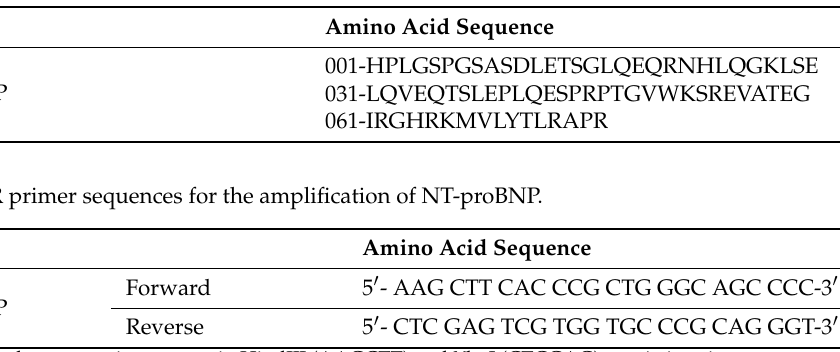
Table 1. NT-proBNP amino acid sequence.